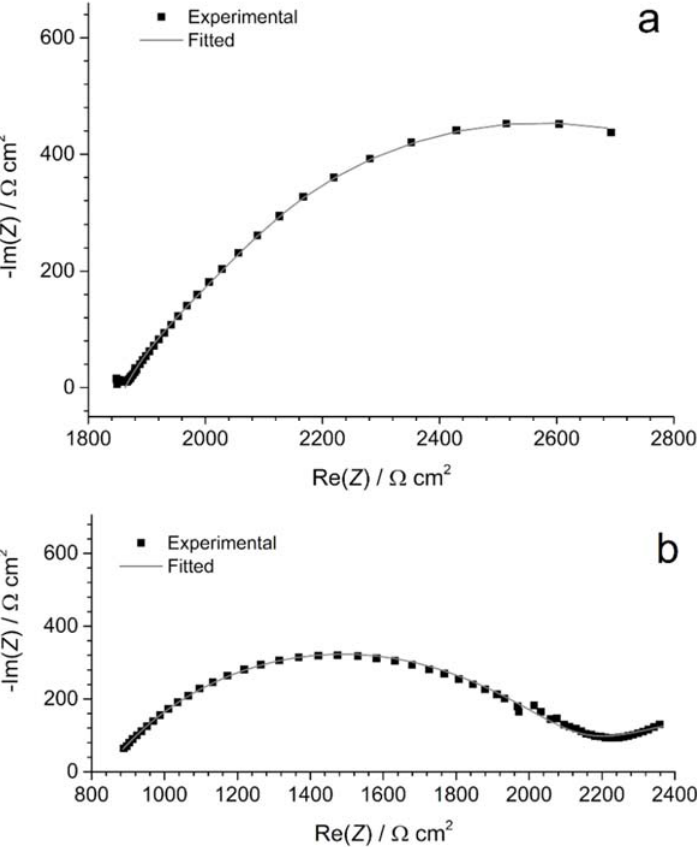
Table 2. Fitted values of EIS data for both coupons at OCP (day 7).